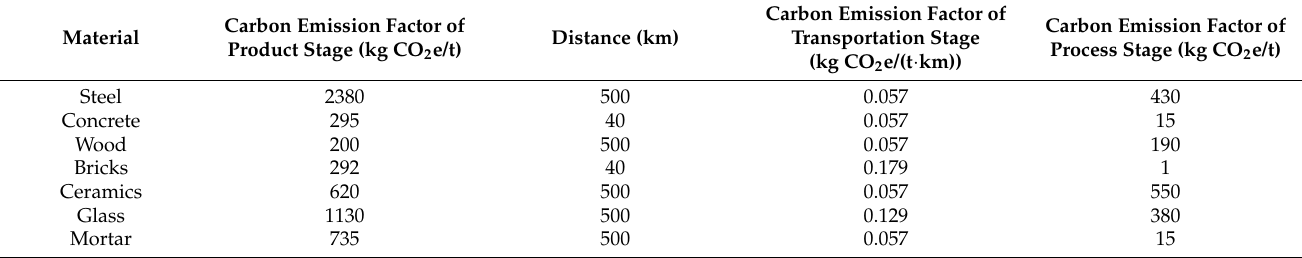
Table 4. Calculation parameters of carbon reduction